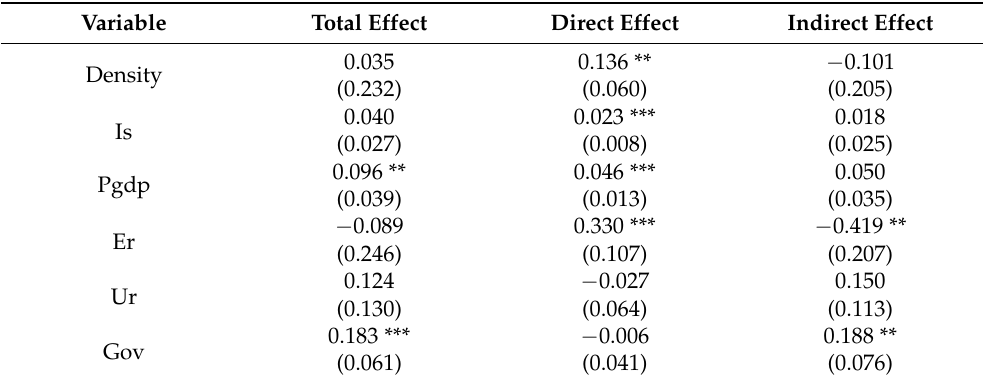
Table 5. The results of the partial differential regression.